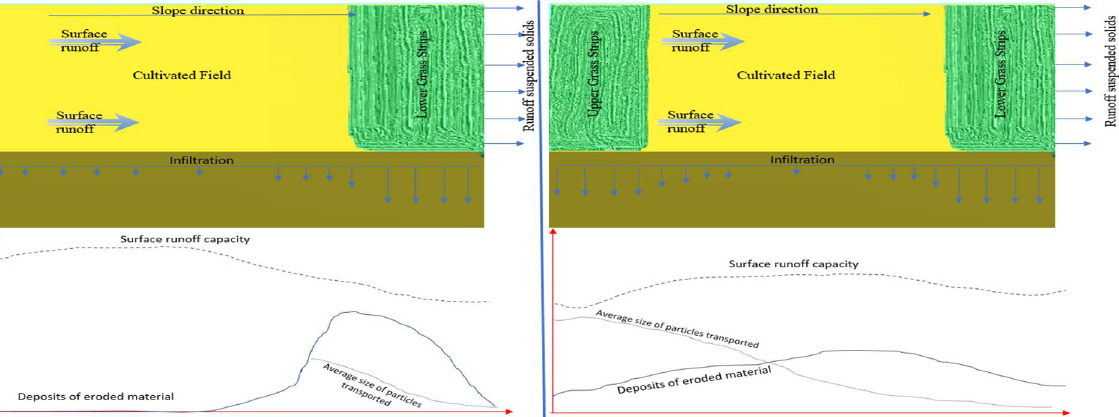
Figure 1. Schematic representation of the fields with 2 m grass strips and the effect on soil–water